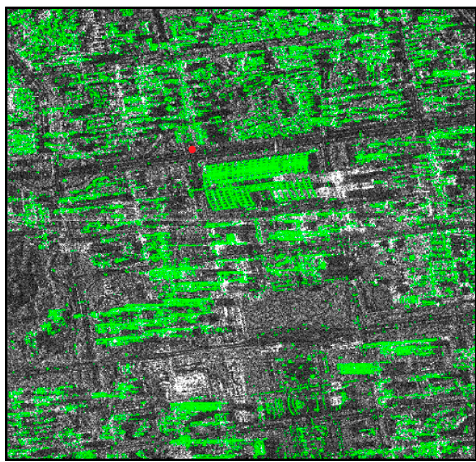
Figure 4. Permanent scatterer (PS) points distribution map. Red dot is the reference point for the unwrapping.